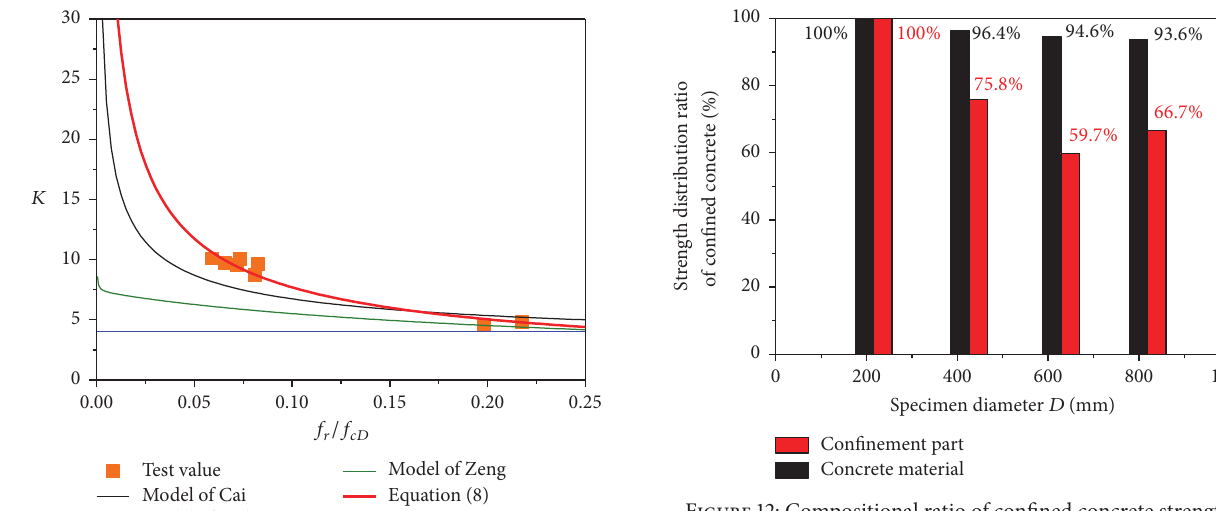
Figure 12: Compositional ratio of confined concrete strength.